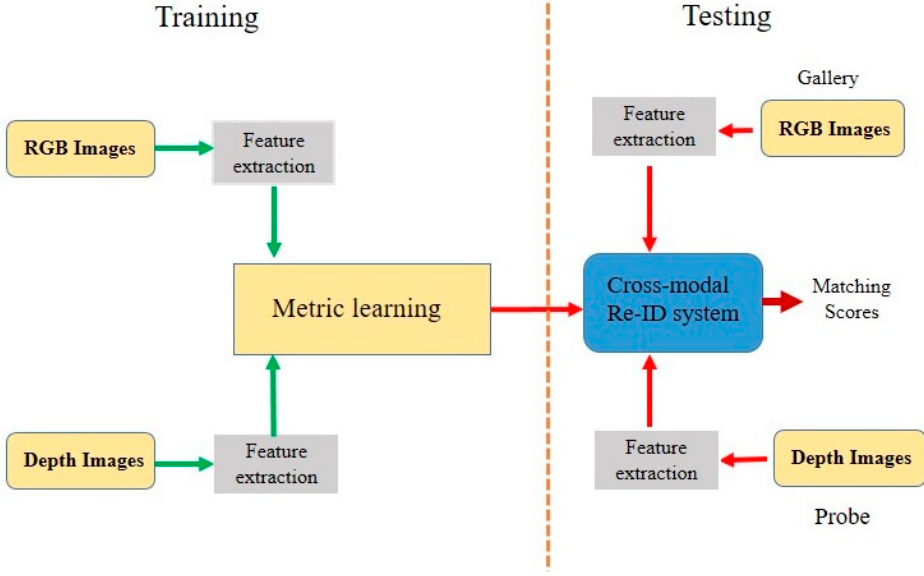
Figure 11. The general architecture of RGB–depth cross-modal